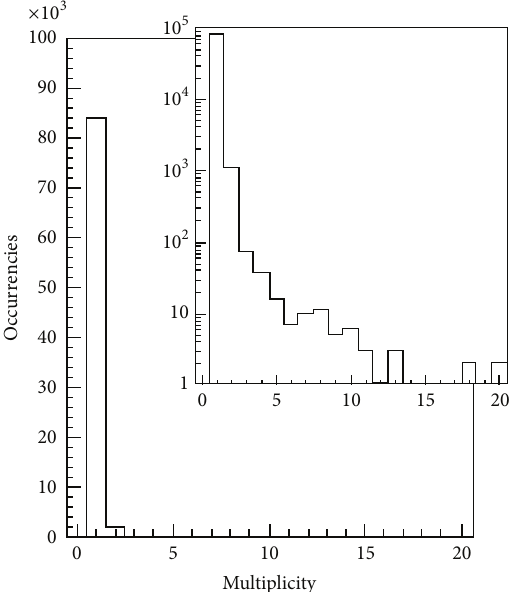
Figure 36: Multiplicity distribution of hit pixels within the frames.